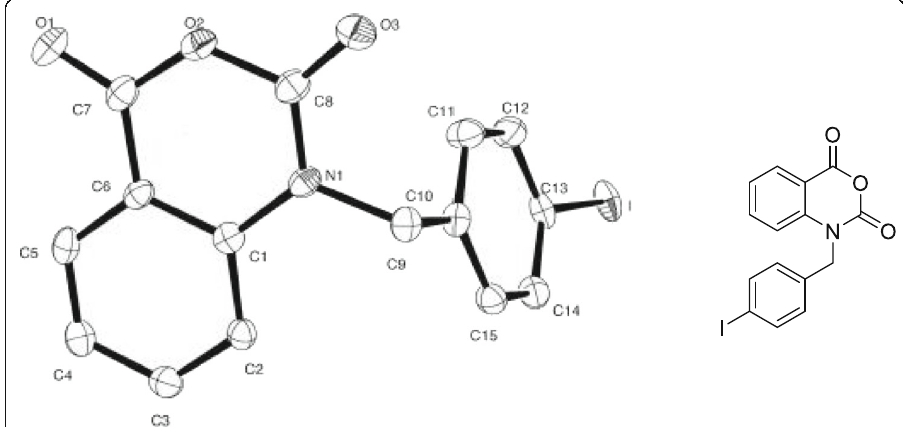
Fig. 3 Crystal structure and chemical drawing of a major product Step 1 in Scheme